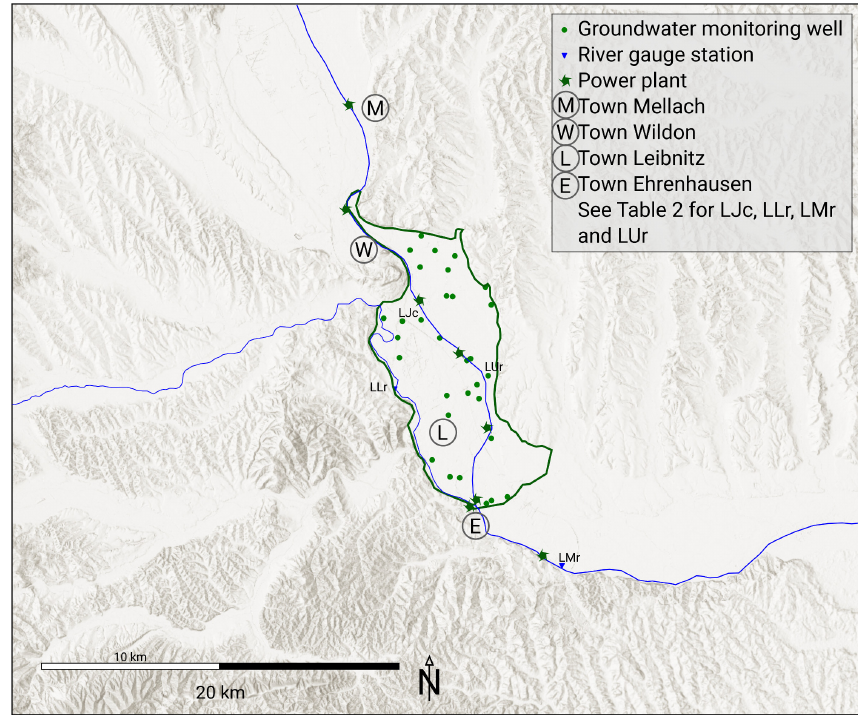
Figure B3. Detailed map for the Leibnitzer Feld